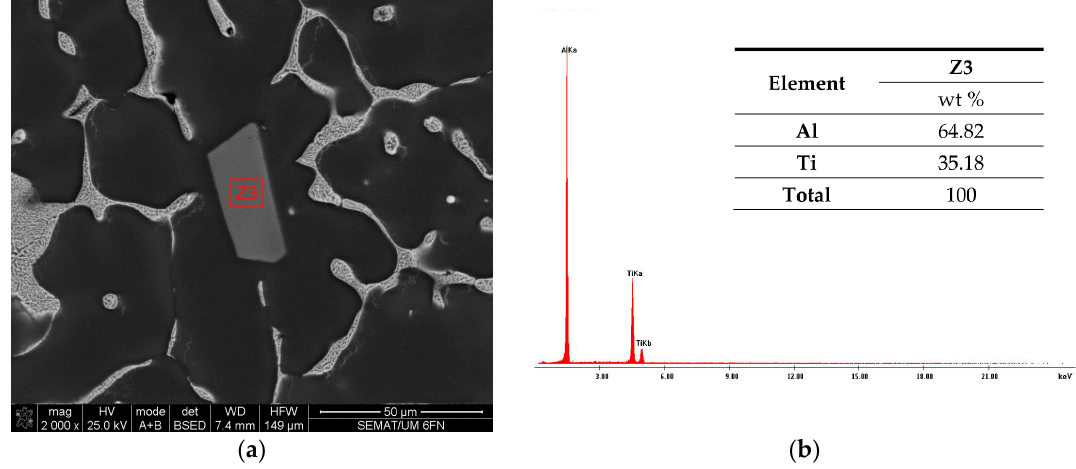
Figure 17. (a ) Very few TiAl 3 particle after USV treatment, batch 45U; ( b ) EDS quantification of the point in ( a ).